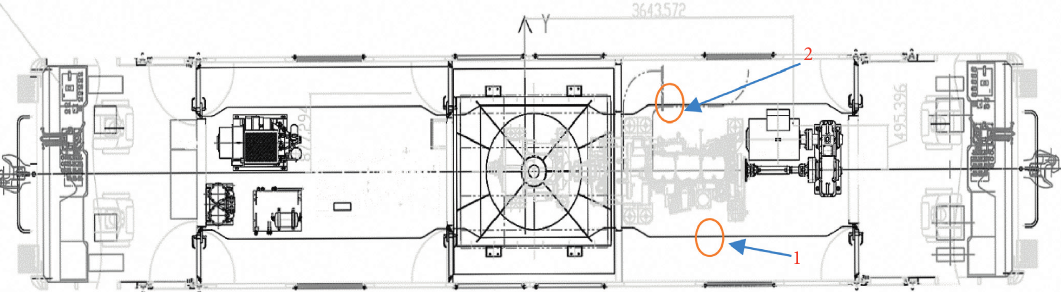
Figure 13: The measuring points of the diesel engine.